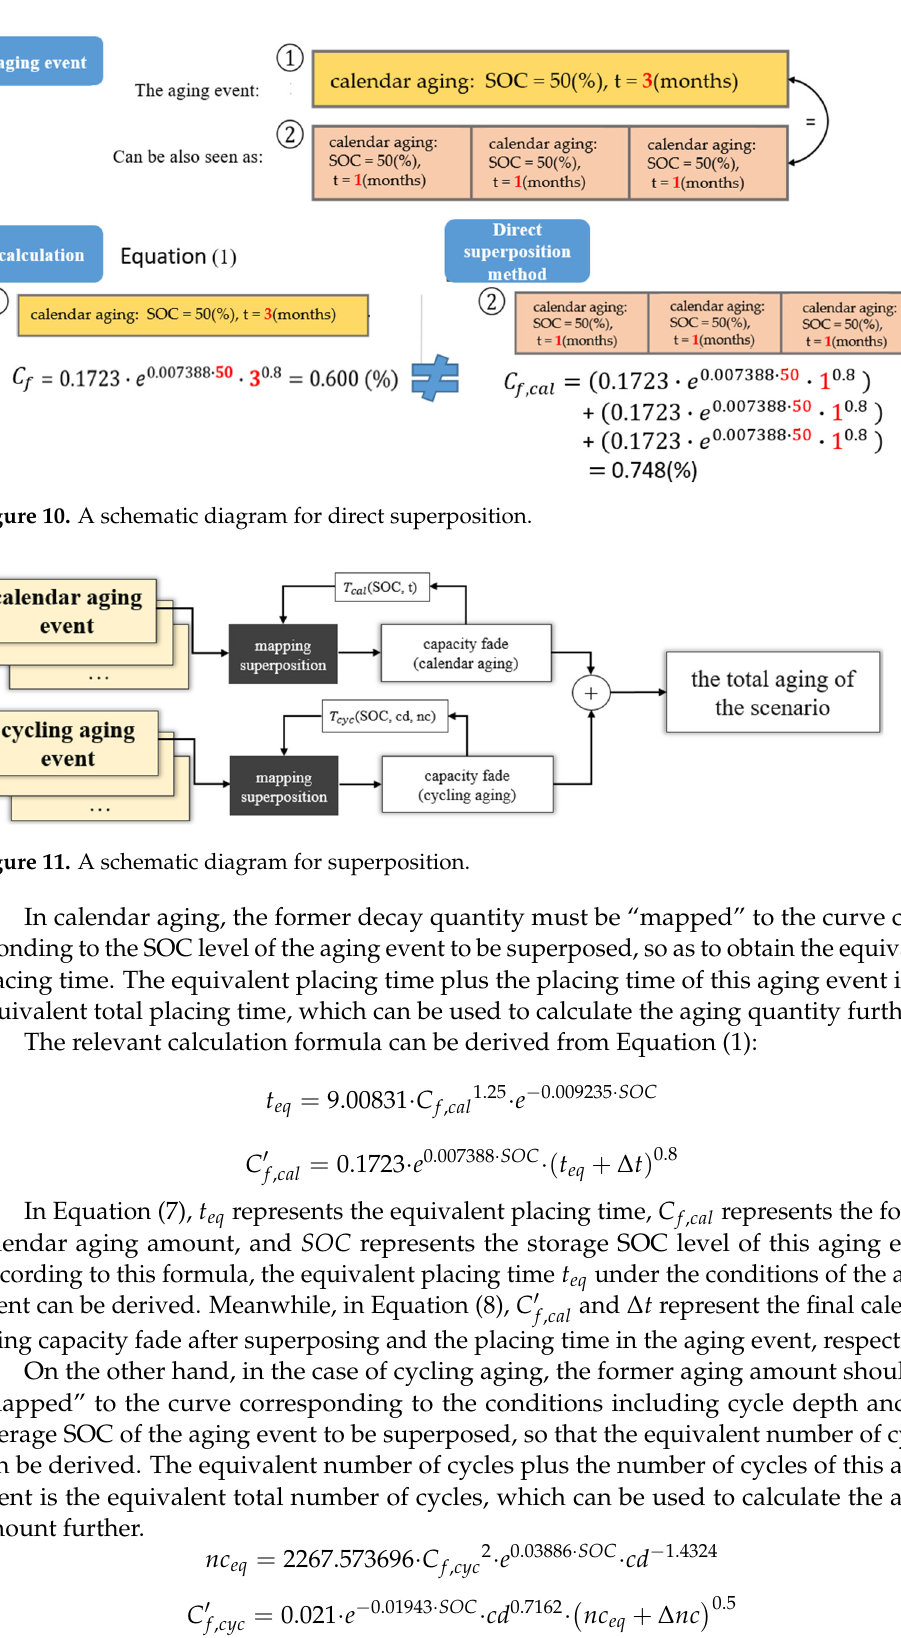
Figure 10. A schematic diagram for direct superposition.